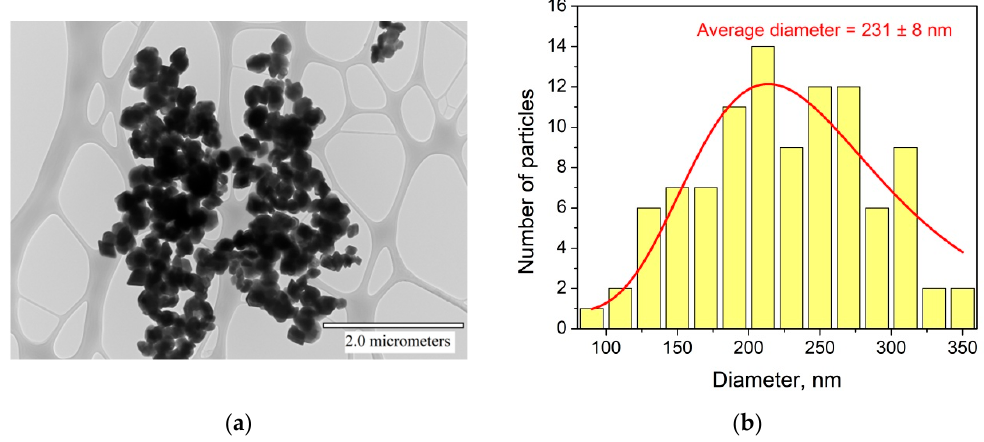
Figure 1. TEM image of Nd 3+ :YF 3 particles ( a ). Size distribution histogram of Nd 3+ :YF 3 particles ( b ) (fitting function is LogNormal from OriginPro.9.0. database).